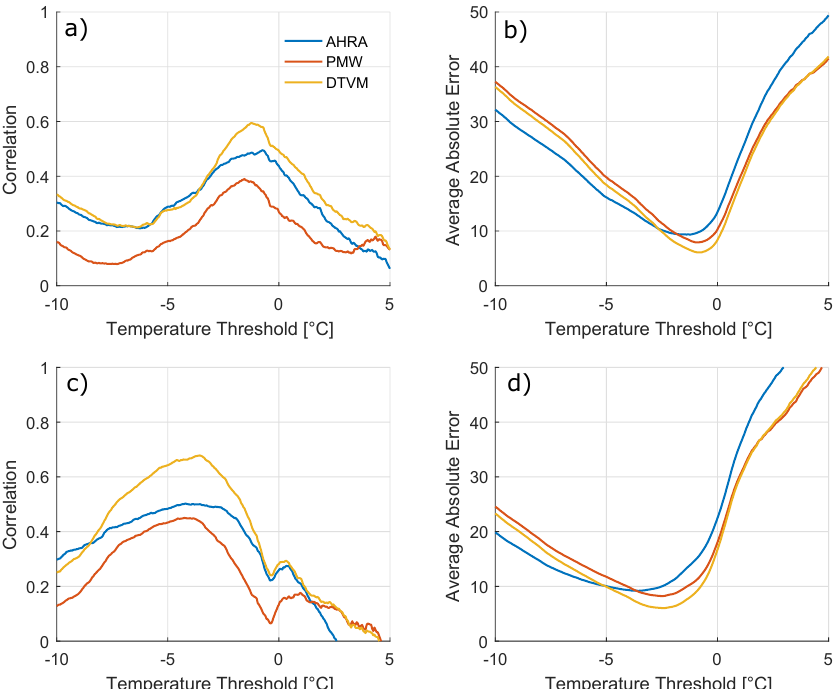
Figure 6. ( a ) Correlation between MO dates derived from daily averaged SAT values for various SAT thresholds ( b ) Absolute difference between MO dates derived from daily averaged SAT values for various SAT thresholds ( c ) Correlation between MO dates derived from 14-day averaged SAT values at various thresholds ( d ) Absolute difference between MOs derived from 14-day averaged SAT values at various thresholds. Statistics were calculated using data points for which all three methods had a MO data from year 2003 to 2011 (6147 points in